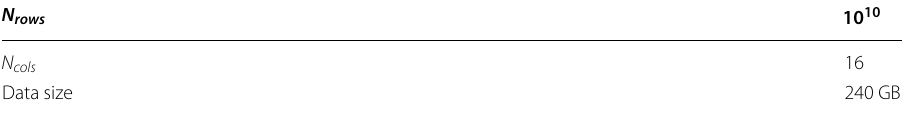
Table 1 Characteristics of the synthetic dataset used for our benchmarks N